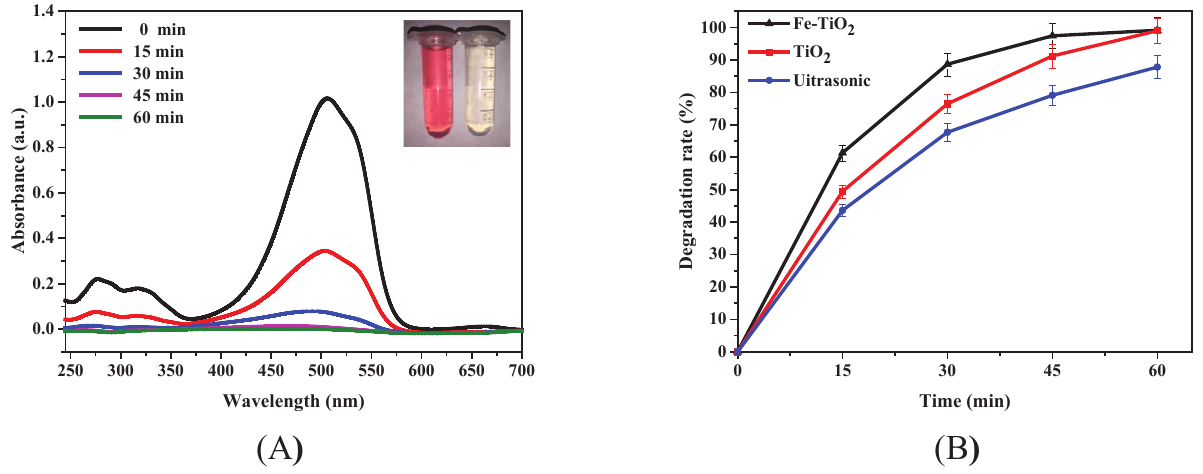
Figure 6: (A): Changes in the absorbance during the degradation of methyl orange. (B): Effect of time on sonocatalytic degradation of methyl orange. (Initial dye concentration = 10 mg/L, Catalyst loading = 0.5 g/L, Ultrasonic frequency = 40 kHz, pH= 3.0 Revolutions =500 r/min, Time=45